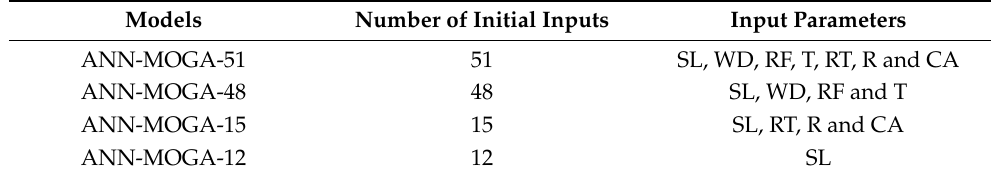
Table 2. Various multi-objective GA-based ANN models using different input variables with lags. Models Number of Initial Inputs Input Parameters